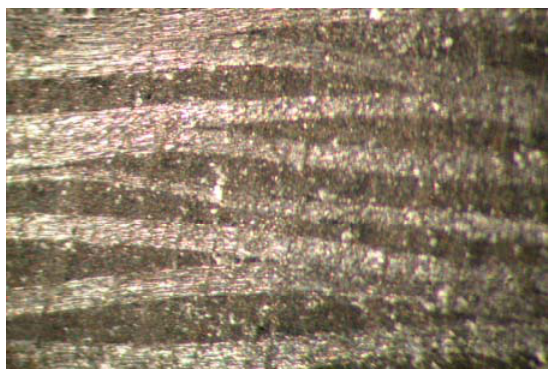
Figure 1: Lateral view photo showing the fibre distribution along of the longitudinal direction of the specimen.